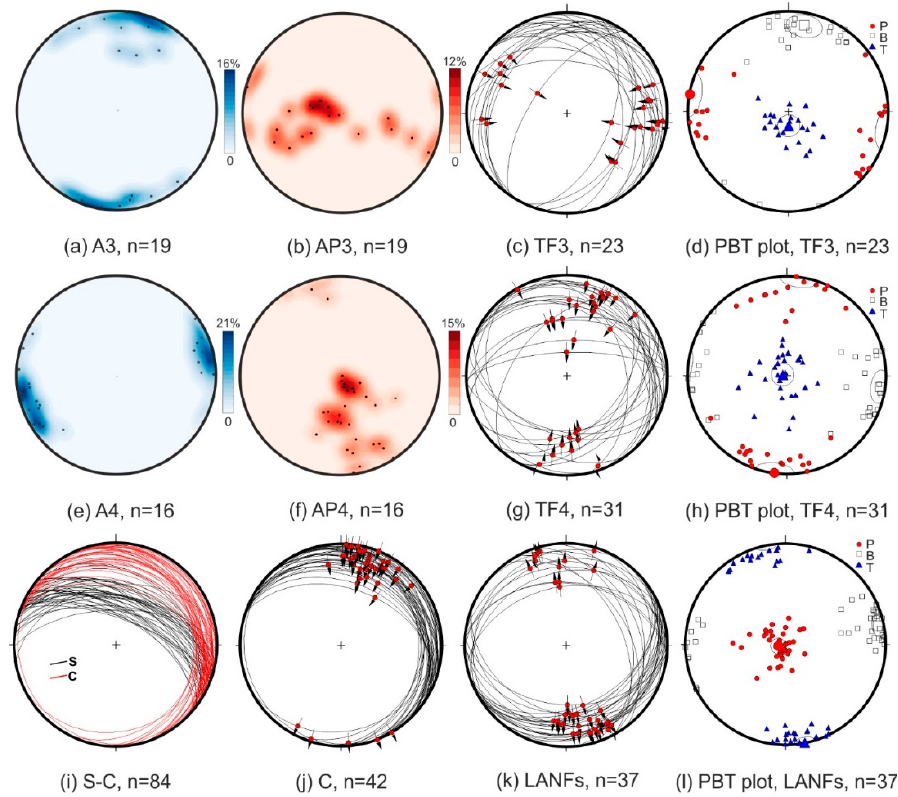
Figure 9. Acerno-Tusciano River (Campagna tectonic window). ( a – l ) Stereographic projections (lower hemisphere, equiareal net) and PBT plots of the analyzed structures described in the text. A—fold axis; AP—axial plane; TF—thrust fault. Color bar indicates the density percentile of the contour plot. ( d ) θ = 26°; mean vectors; P: 280/01 (R = 81%); T: 011/14 (R = 84%); B: 178/78 (R = 90%). ( h ) θ = 26°; mean vectors; P: 187/00 (R = 79%); T: 097/06 (R = 82%); B: 283/86 (R = 85%). ( l ) θ = 70°; mean vectors; P: 258/84 (R = 92%); T: 079/07 (R = 91%); B: 169/01 (R = 92%).